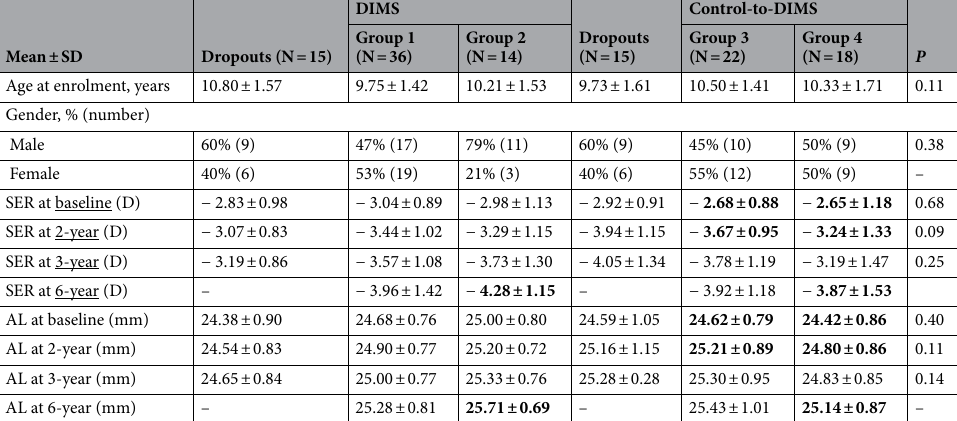
Table 1. Summary of demographic data for the dropouts and the children who completed the 6-year follow-up study. The bold figures in the rows of SER and AL represent the time of wearing SV spectacle lenses and the unbold figures represent the time of wearing DIMS spectacle lenses.